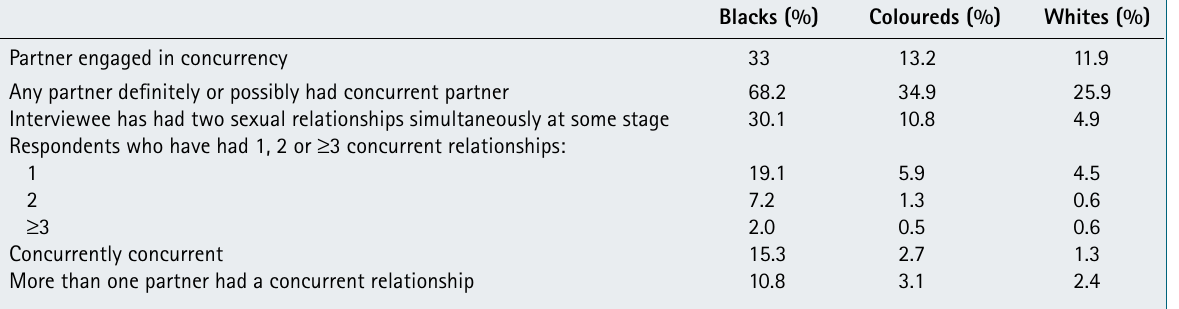
TABLE ii. ConCURREnCY RATES BY RACE AMonG 14 - 25-YEAR-oLD CApEToniAnS